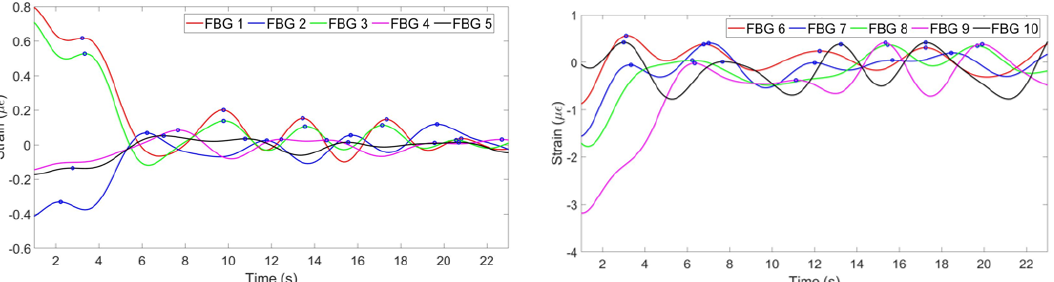
Figure 20. Breathing pattern for the second volunteer in the lying position detected by: FBGs on the chest ( left ) and abdomen regions ( right ).